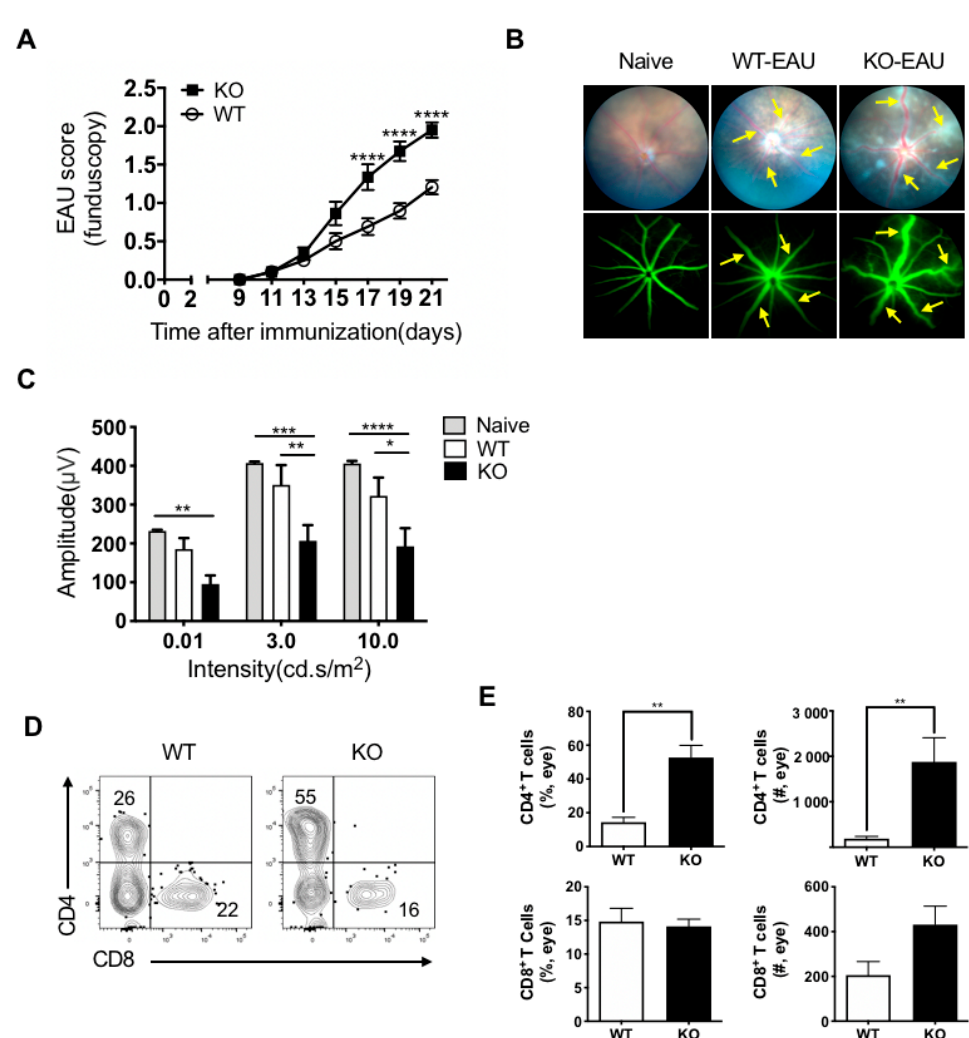
Figure 1. IL-27Ra − / − mice developed more severe EAU than their WT littermates. EAU was induced in IL-27R α − / − (KO) mice and their WT littermates by active immunization with retinal antigen IRBP 1–20 peptide and CFA in the presence of PTx. ( A ) Clinical score of EAU in KO mice and WT littermates. Data represent the means ± SEMs (WT: n = 22 eyes; KO: n = 20 eyes). **** p < 0.0001, two-way ANOVA. ( B ) Representative retinal images assessed by funduscopy (upper) and fluorescein angiography (bottom) from naïve, WT, and KO EAU mice at the peak of disease on day 21 post-immunization. Vasculitis and perivascular cellular exudates are marked by arrows. ( C ) The b-wave amplitude of scotopic ERG response among naïve, WT, and KO mice at the peak of EAU (day 21). Data represent the means ± SEMs from a representative of three independent experiments, and each group contained at least 6 samples. * p < 0.05, ** p < 0.01, *** p < 0.001, **** p < 0.0001, two-way ANOVA. ( D , E ) Inflammatory cells were isolated from EAU eyes at the peak of disease. ( D ) Representative FCM plots. ( E ) Frequency (%) and actual number (#) of CD4 + and CD8 + T cells were assessed in the eyes from WT and KO EAU mice. Data represent the means ± SEMs (WT: n = 5 eyes; KO: n = 9 eyes). ** p < 0.01, Mann–Whitney U